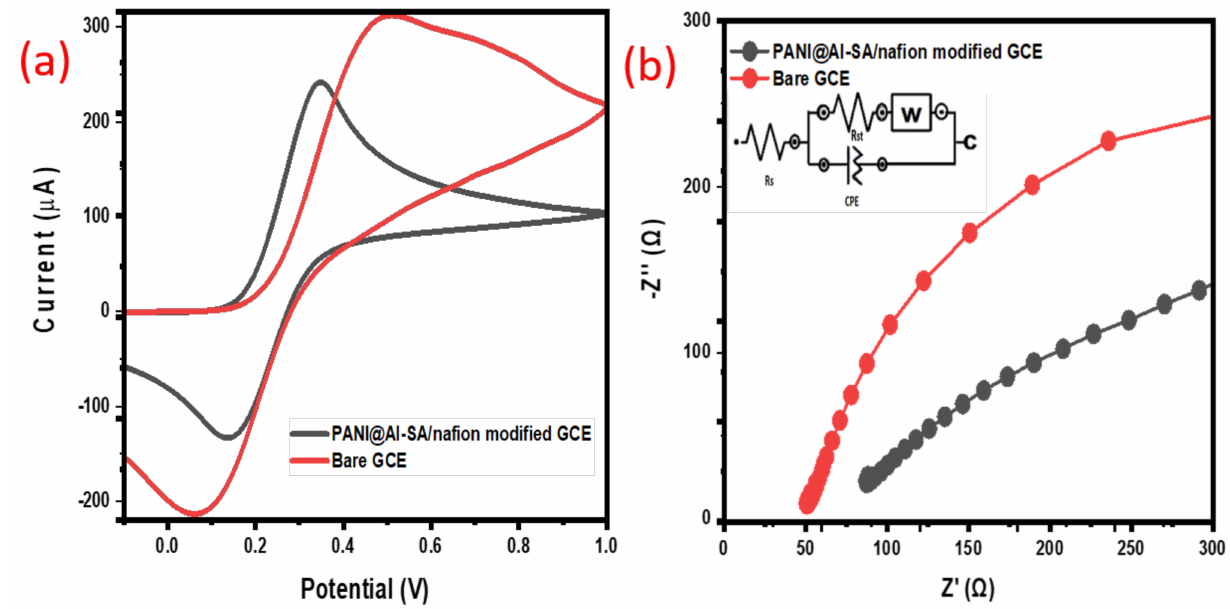
Figure 6. ( a ) Cyclic Voltammograms of 0.1 mM [Fe(CN)6] 3 − /4 − in0.1M KCl at a scan rate of 100 mV/s, ( b ) Nyquist plot for bare and PANI@Al-SA/nafion modified GCEs in 0.1 mM [Fe(CN)6] 3 − /4 − /0.1 M KCl. The inset represents a Randel circuit diagram for the system where is Rs is the resistance of the solution, Rct is the resistance of the charge transfer, CPE is constant phase element and W is Warburg